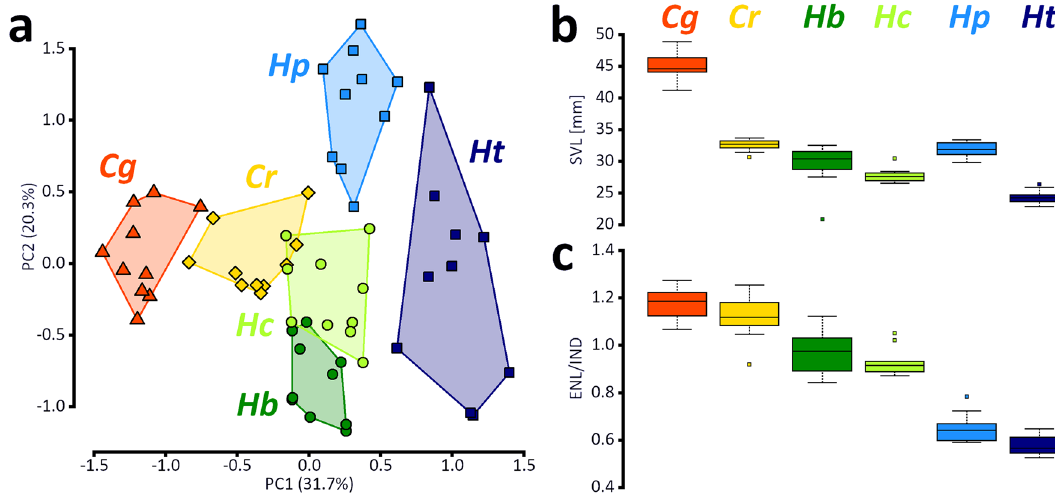
Figure 5. Morphometric analyses of external characters of Congolius gen. n. and relative ( Cryptothylax ) or similar ( Hyperolius ) genera from the lowland Congo Basin. Four Hyperolius species represent two phylogenetic clades (see Methods for details). ( a ) Principal component analysis of body shape, ( b ) variation of SVL as boxplots, ( c ) variation of the ENL/IND ratio as boxplots. Boxplots display average values (line), upper and lower quartiles (box), minimums and maximums without outliers (whiskers), and outliers (dots). Cg ( Cryptothylax greshoffii ), Cr ( Congolius robustus gen. et comb. n.), Hb ( Hyperolius balfouri ), Hc ( H. cinnamomeoventris ), Hp ( H. phantasticus ), and Ht ( H. tuberculatus